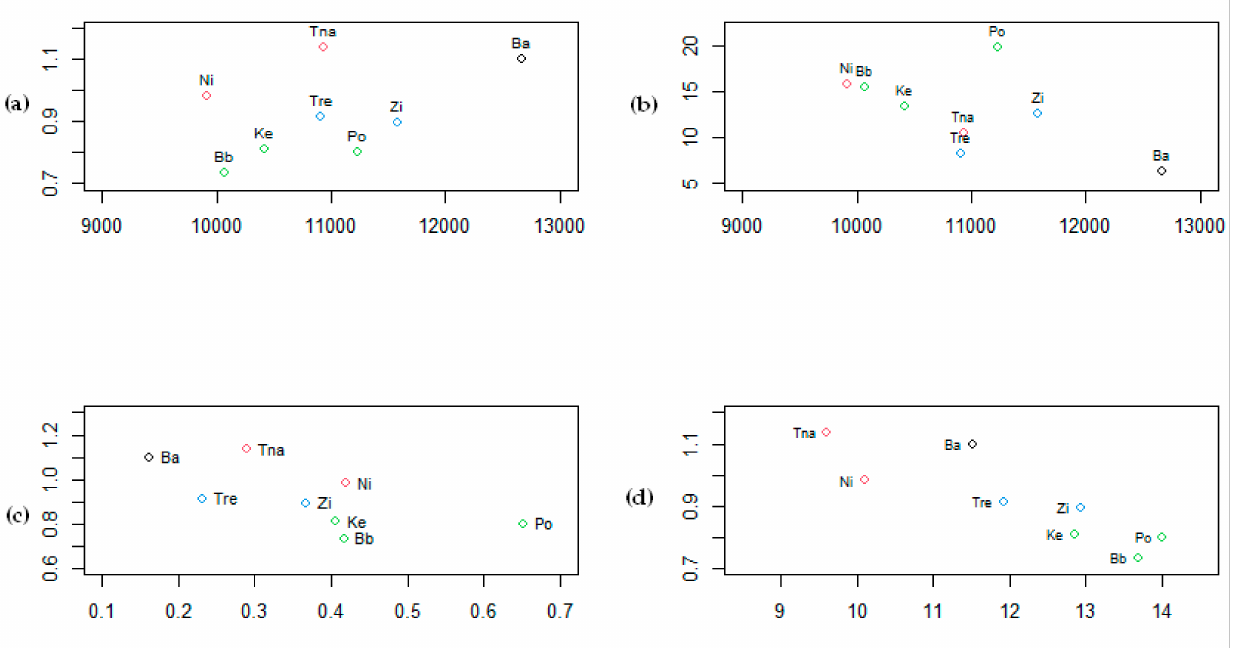
Figure 14. Comparison of indexes after clustering 2012: ( a ) Communal waste per household in t per year according net expenses of household in € ; ( b ) measure of poverty risk—60% of median at percentage (%) according to net expenses of household in € ; ( c ) communal waste per household in t per year according to people below the poverty line per 1 household; ( d ) communal waste per household in t per year according to waste costs in € with relation to